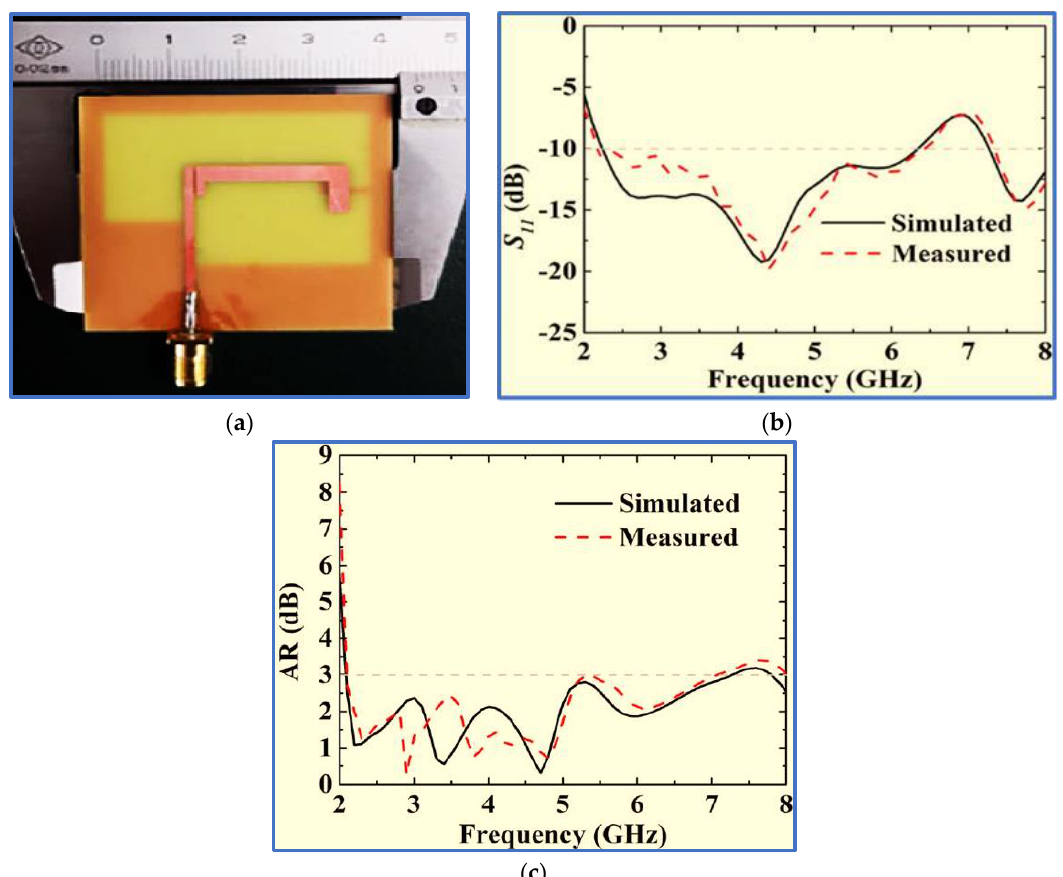
Figure 18. ( a ) Fabricated prototype of a microstrip feeding CP slot antenna. ( b ) Simulated and measured S11 results. ( c ) Simulated and measured AR results [18].